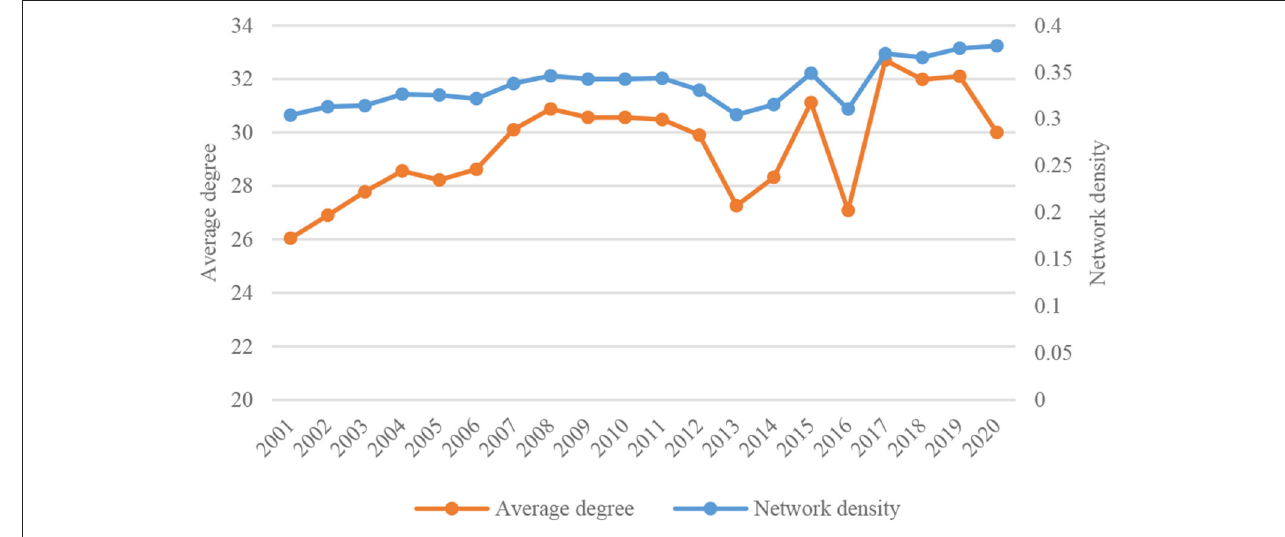
FIGURE 1 | Changes in average degree and density of global TCM trade network in